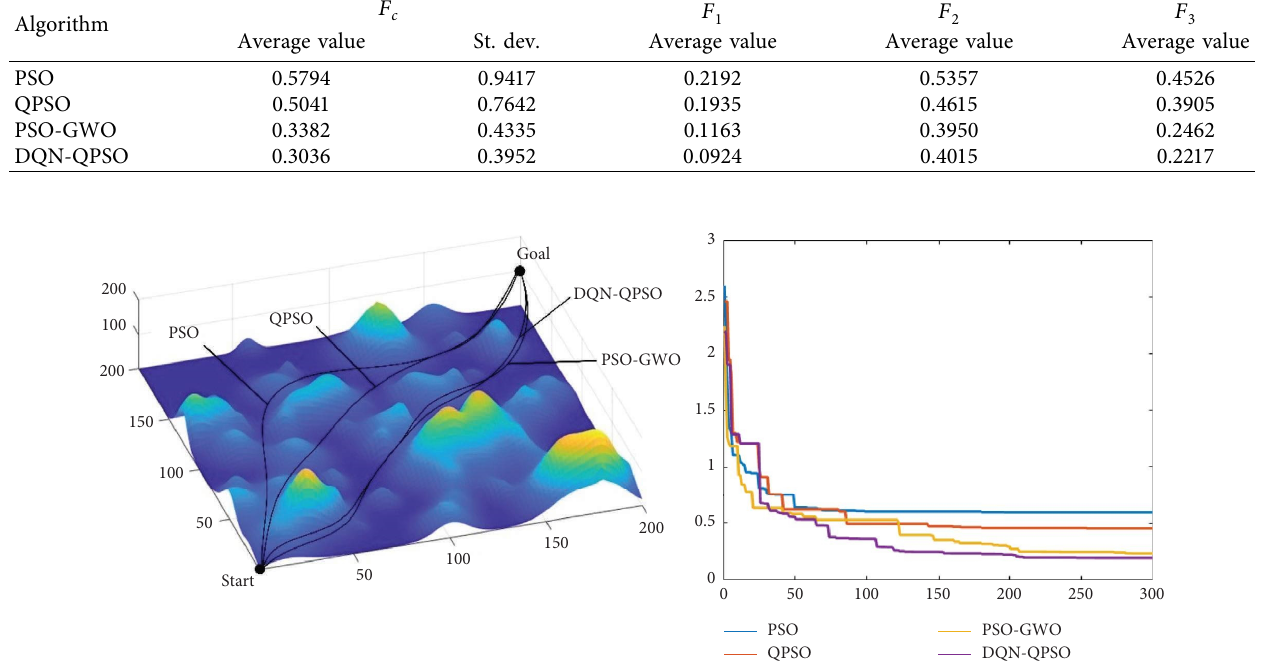
Figure 7: Path planning diagram in obstacle environment. Table 3: Comparison of the results of the two